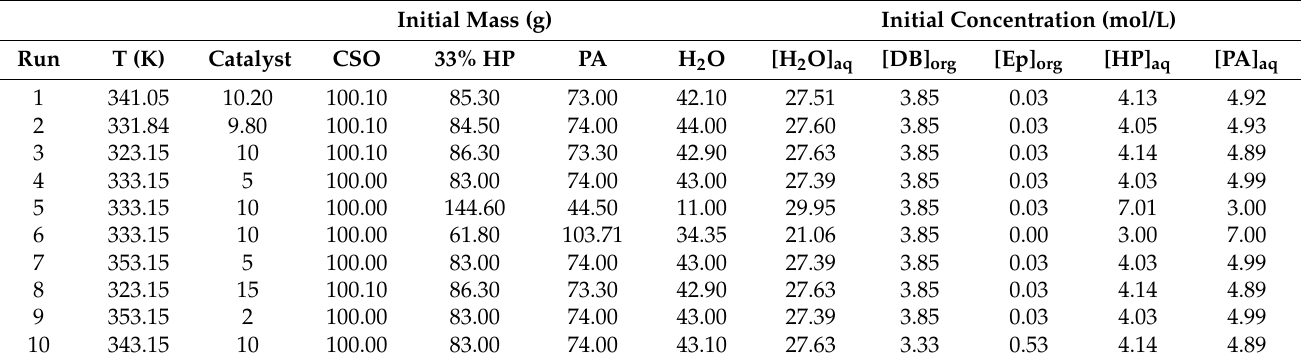
Table 1. Experimental matrix for the modeling of epoxidation of cottonseed oil. (DB: double bond, EP: epoxide, PA: propionic acid, and HP: hydrogen peroxide). Initial Mass (g)